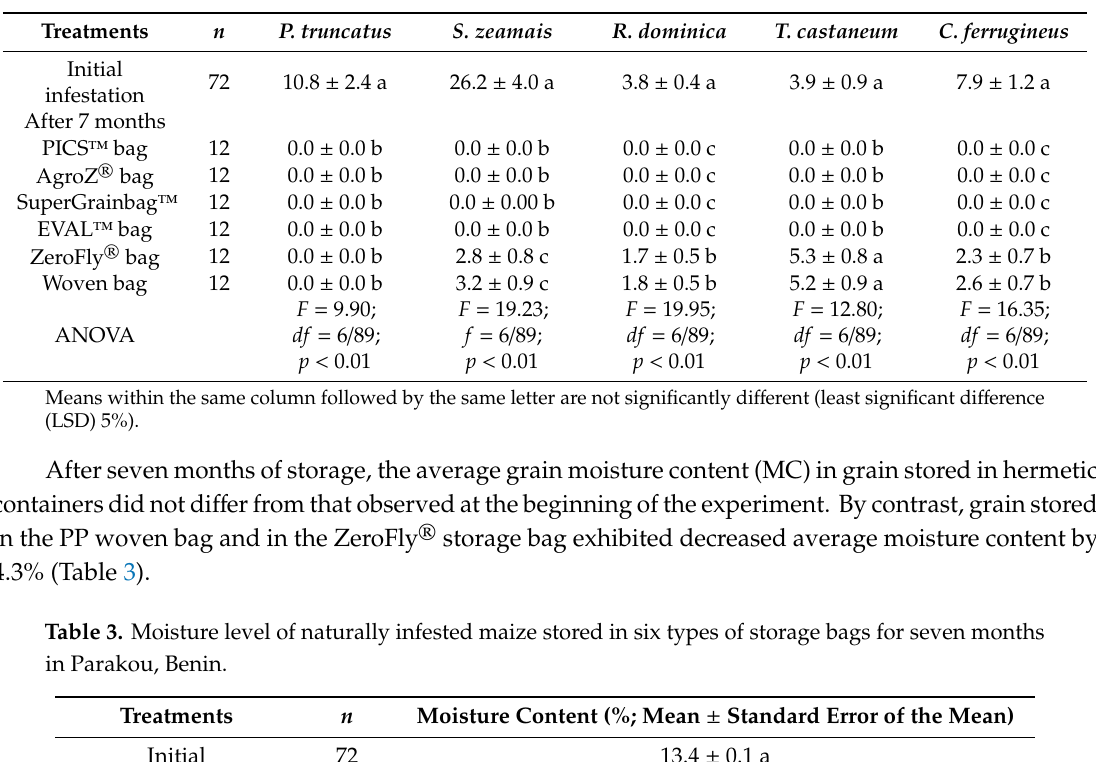
Table 2. Live insect population (number per 500 g) in naturally infested maize grain stored for seven months using six storage bags in Parakou, Benin.